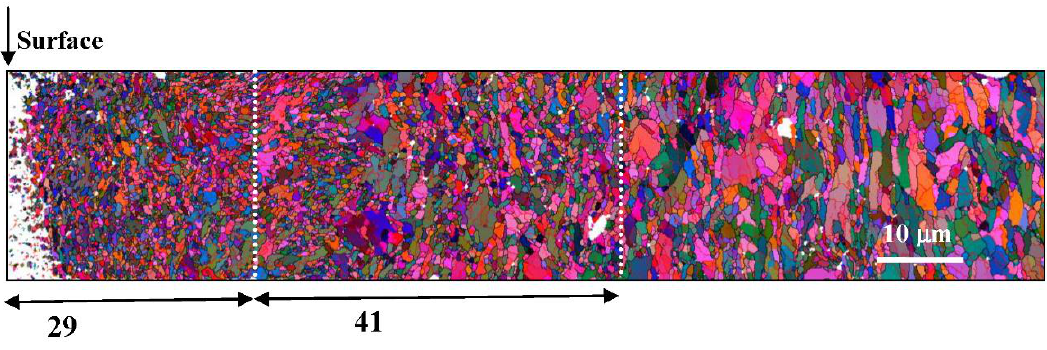
Figure 3. Cross-sectional EBSD orientation color map of the reduced activation steel after SMAT.